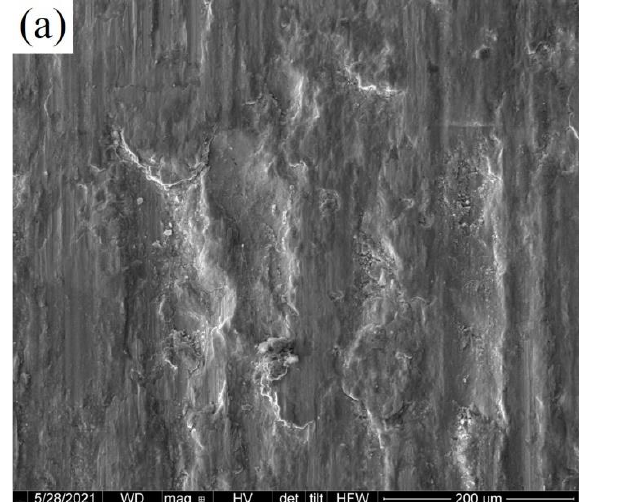
Figure 8. The dependence of the friction coefficient on the sliding distance of the untreated and PENC samples.